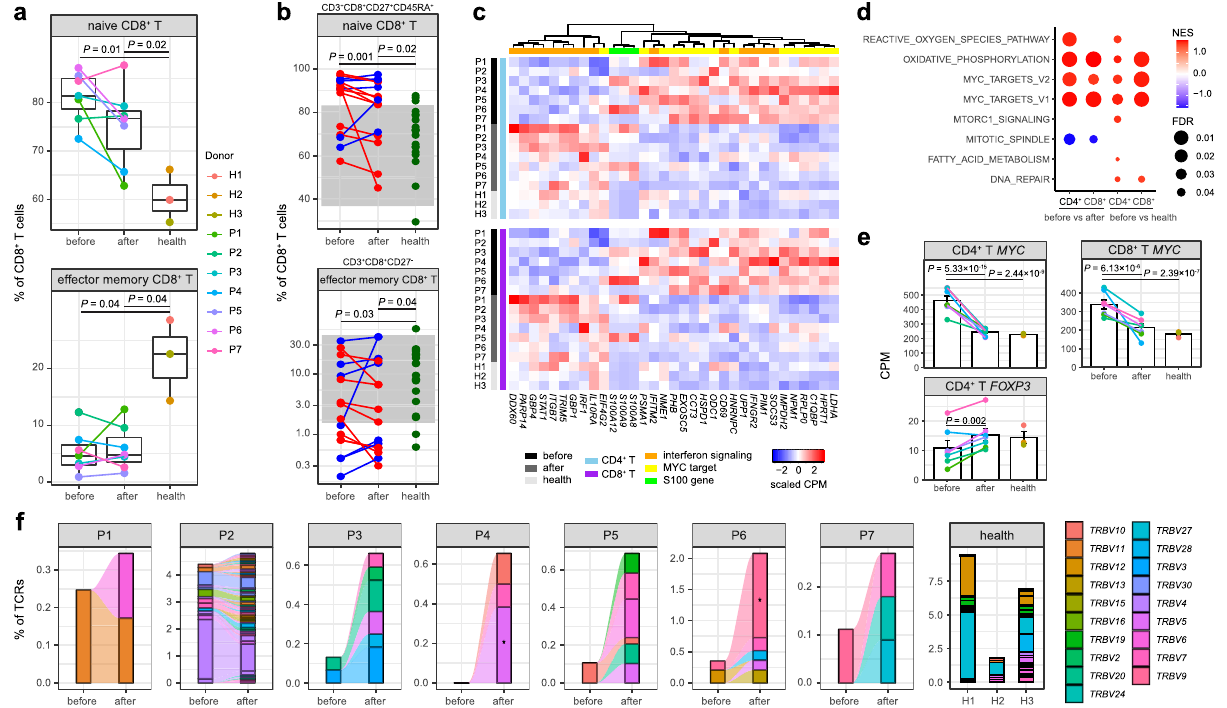
Fig. 5 Characterization of T cells and TCRs. a Percentage of naive and effector memory CD8 + T cells across conditions recovered by scRNA-seq (KD patients n = 7, healthy controls n = 3). The middle line of the boxplot is the median, the lower and upper hinges correspond to the fi rst and third quartiles, and the whiskers extend from the hinge to the farthest data point within a maximum of 1.5× interquartile range. The samples are colored according to donors. P -values are calculated by using the two-sided t -test. b Percentage of naive (CD3 + CD8 + CD27 + CD45RA + ) and effector memory (CD3 + CD8 + CD27 − ) CD8 + T cells by fl ow cytometric validation on additional KD patients ( n = 16) and healthy controls ( n = 20). Patients with a decreased percentage after therapy are colored in red, and patients with an increased percentage after therapy are in blue. Healthy controls are colored in green. The gray areas represent the reference ranges of the panel. P -values between conditions are calculated by using the two-sided t -test. The percentage of effector memory CD8 + T cells is plotted and tested on the log scale. c Heat map of DEGs with functional enrichment shared in CD4 + and CD8 + T cells. Gene expression on the sample level is measured by the counts per million mapped reads (CPM), which is then scaled across samples. d Signi fi cant hallmark gene sets identi fi ed by GSEA 41 . The dot size indicates the FDR, and the dot color indicates the normalized enrichment score (NES). A positive NES suggests that the gene set is enriched in upregulated genes before therapy, and a negative NES suggests it is enriched in downregulated genes before therapy. e Expression level of MYC and FOXP3 in T cells across conditions (KD patients n = 7, healthy controls n = 3). The bar plot depicts mean CPM and standard error of the mean. The samples are in the same colors as a . P -values are calculated with DESeq2 31 (two-sided). f TCR clonotype tracking in each patient. The clonotype composition is represented by stacked bar plots, which are colored according to TRBV families. Only clonotypes with clonal size ≥ 3 are plotted, and proportion of TCRs in these clonotypes are compared before and after therapy by using the two-sided Fisher ’ s exact test. Individual clonotypes with FDR < 0.01 are marked with stars. Source data are provided in the Source Data fi